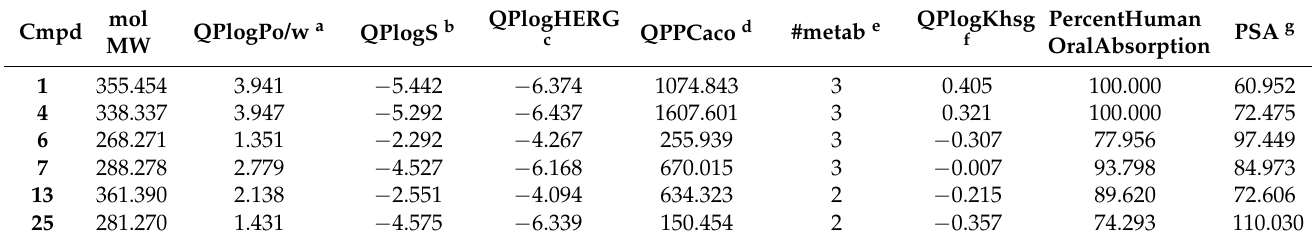
Table 4. Predicted pharmacokinetic properties of the most interesting